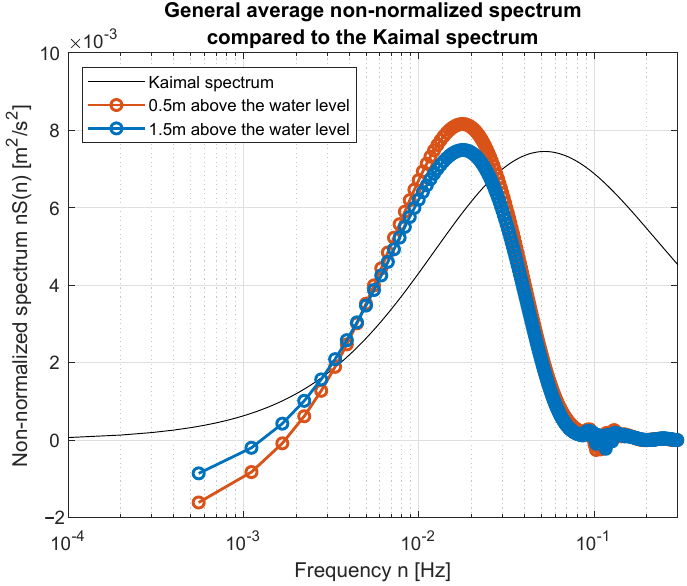
Figure 19. Weak wind (3 BFT in ship scale) compared to Kaimal